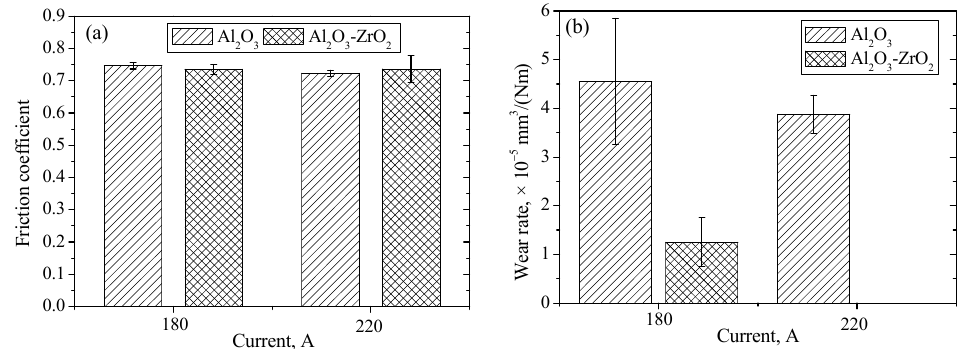
Figure 6. Friction coefficients ( a ) and specific wear rates ( b ) of Al 2 O 3 and Al 2 O 3 -ZrO 2 coatings. The average wear rates of the alumina coatings deposited at 180 and 220 A were 4.55 × 10 − 5 and 3.88 × 10 − 5 mm 3 /Nm, respectively (Figure 6b). The addition of ZrO 2 reduced the specific wear rate down to 1.25 × 10 − 5 mm 3 /Nm for Al 2 O 3 -ZrO 2 deposited at 180 A. The normalized wear rate was found to immeasurable, reasons owing to mere bulk-material transfer leading to plastic deformation, when the alumina-zirconia coating was deposited at 220 A. It should be noted that the wear rate of AISI 304 L steel was 1.17 × 10 − 4 mm 3